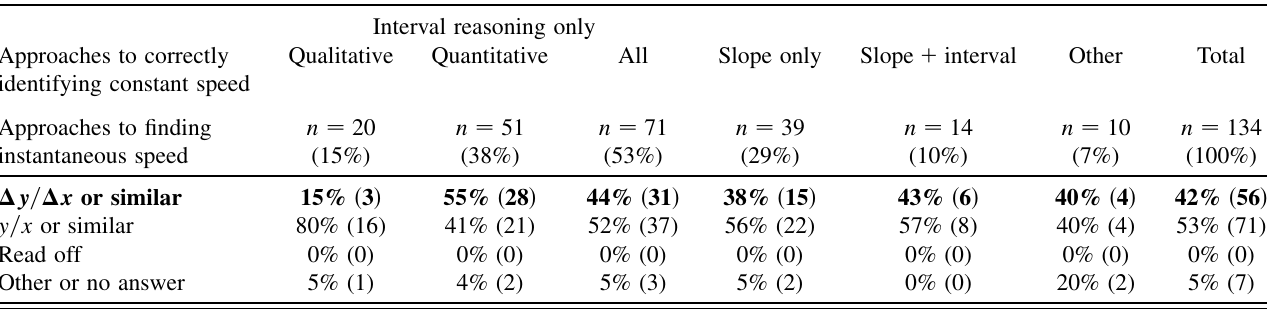
TABLE VIII. Post-test results linking the reasons students gave for correctly identifying constant speed with how they determined a value for the rate of change at one particular instant. For an example of how to read the table, see the caption of Table II. Interval reasoning only Approaches to